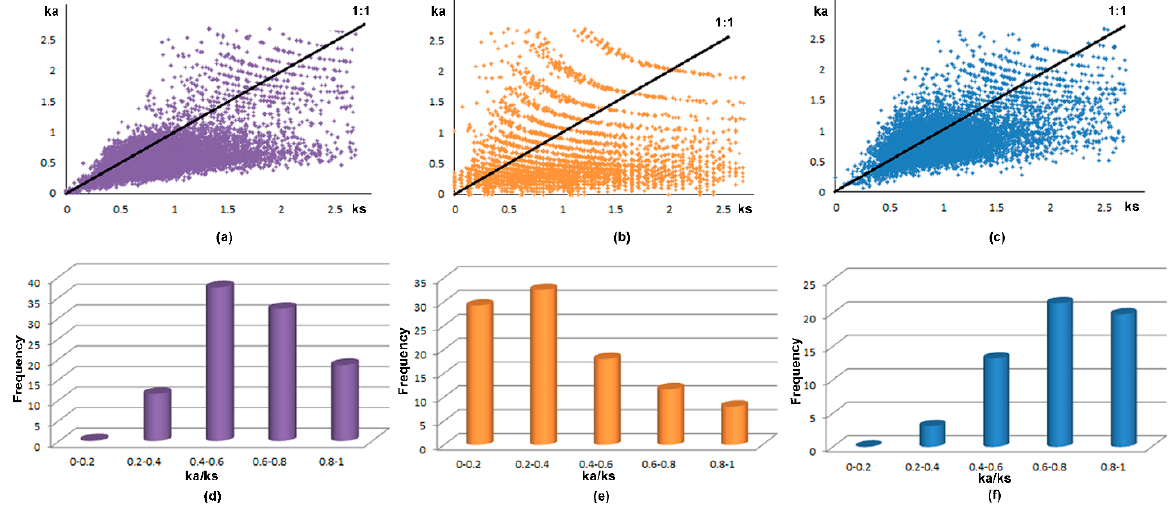
Figure 3. The distribution and frequency of Ka/Ks values. The purple, blue, and orange colors represent the maize, rice, and Arabidopsis, respectively. ( a ), ( b ) and ( c ) show the Ka/Ks distribution. The line in black is the boundary of Ka/Ks = 1. ( d ), ( e ), and ( f ) represent the frequency distribution of Ka/Ks <